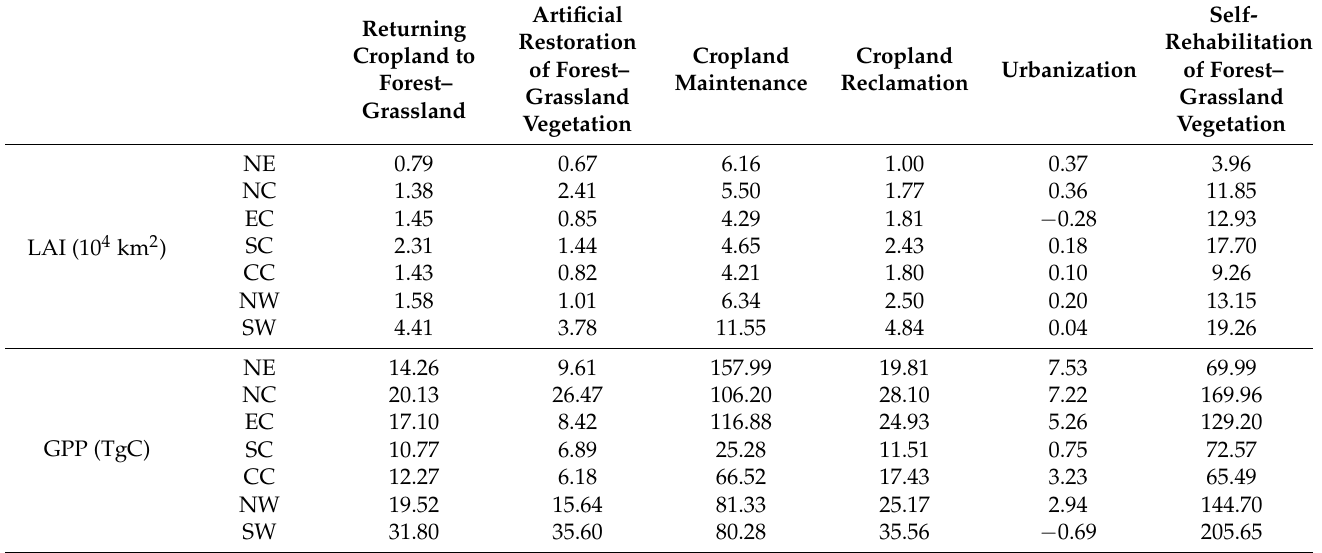
Table 5. Total changes in the LAI and GPP in the land use change areas in each region from 2000 to